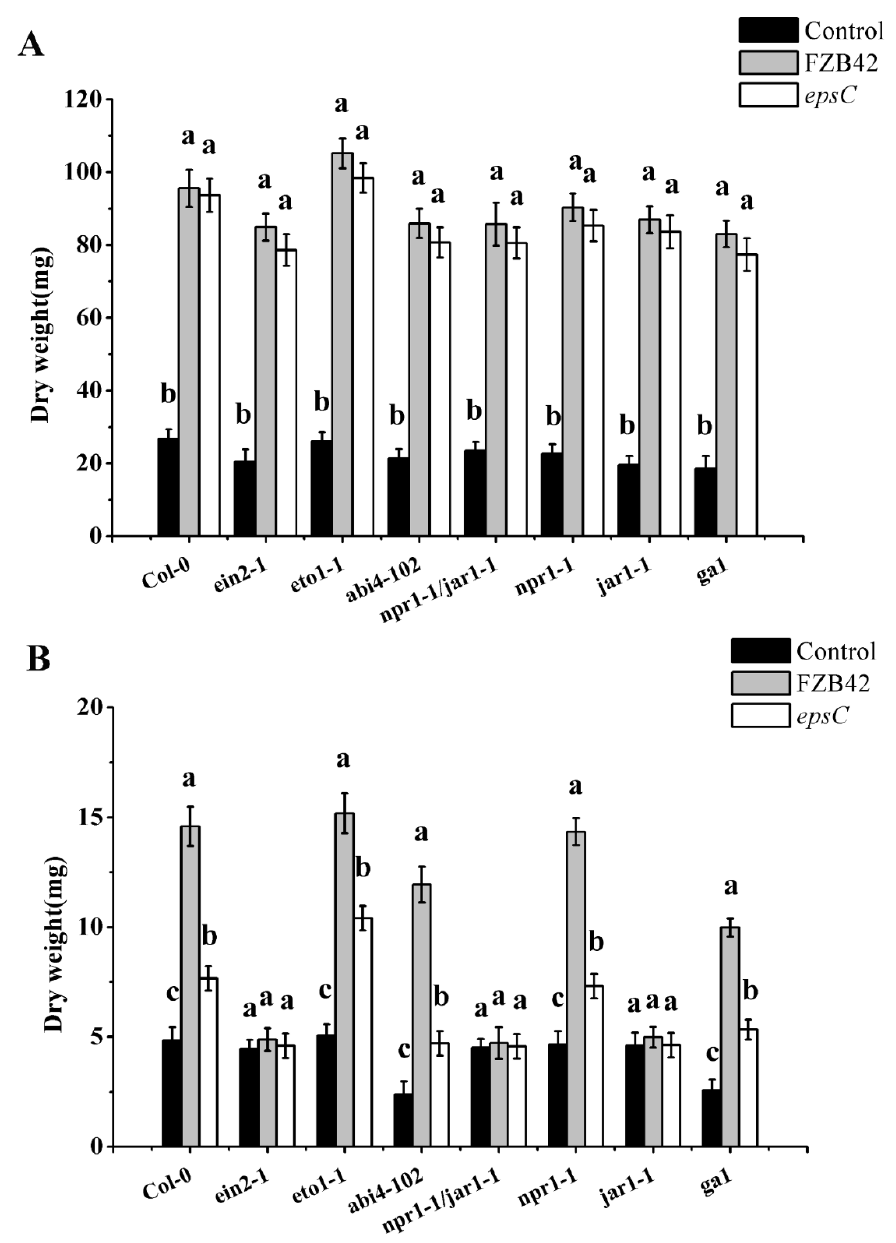
Figure 5. The effect of inoculation with either wild type FZB42 or the epsC mutant on the accumulation of dry matter by well-watered and drought seedlings of Arabidopsis mutants ein2-1 (ethylene insensitive), eto1-1 (ethylene over-producer), jar1-1 (jasmonate insensitive), abi4-102 (ABA insensitive), ga1 (gibberellin-responsive male-sterile dwarf), npr1-1 (salicylic acid insensitive), and the npr1-1/jar1-1 double mutant. Dry weight of Arabidopsis mutants under well-watered condition ( A ), dry weight of Arabidopsis mutants under drought condition ( B ). Values are shown as means, with the whiskers representing the standard error (SE, n = 18). Different letters above each column indicate statistically significant ( p < 0.05) differences in mean performance.